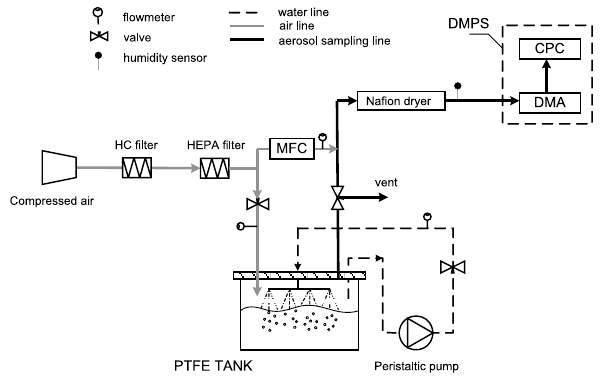
Fig. 6. Schematic of experimental set-up for the measurement of the size distribution of primary sea spray generated by water im-